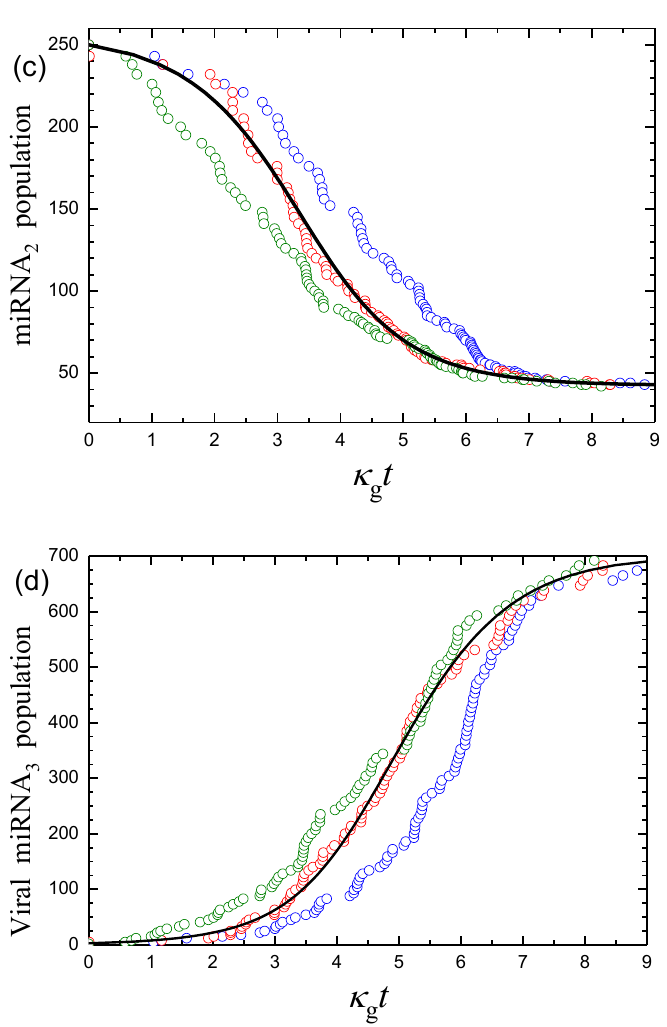
Figure 4. ( a ) G, ( b ) mRNA 1 , ( c ) miRNA 2 , and ( d ) miRNA 3 populations as a function of κ g t for n g ( 0 ) = 1. The mean-field kinetics calculated according to Equations (19) and (20) are shown by solid lines. Open circles exhibit three runs of the corresponding MC kinetics. The parameters are as in the case of Figure 2c.